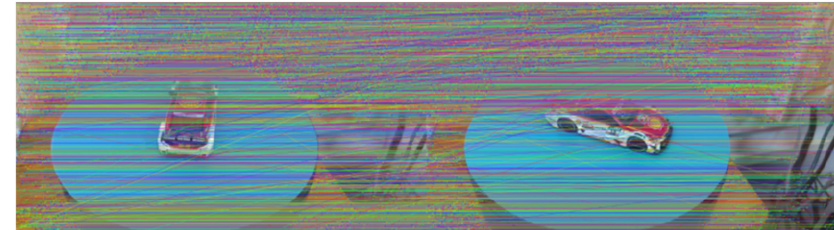
Figure 10. The useless matches between two images.